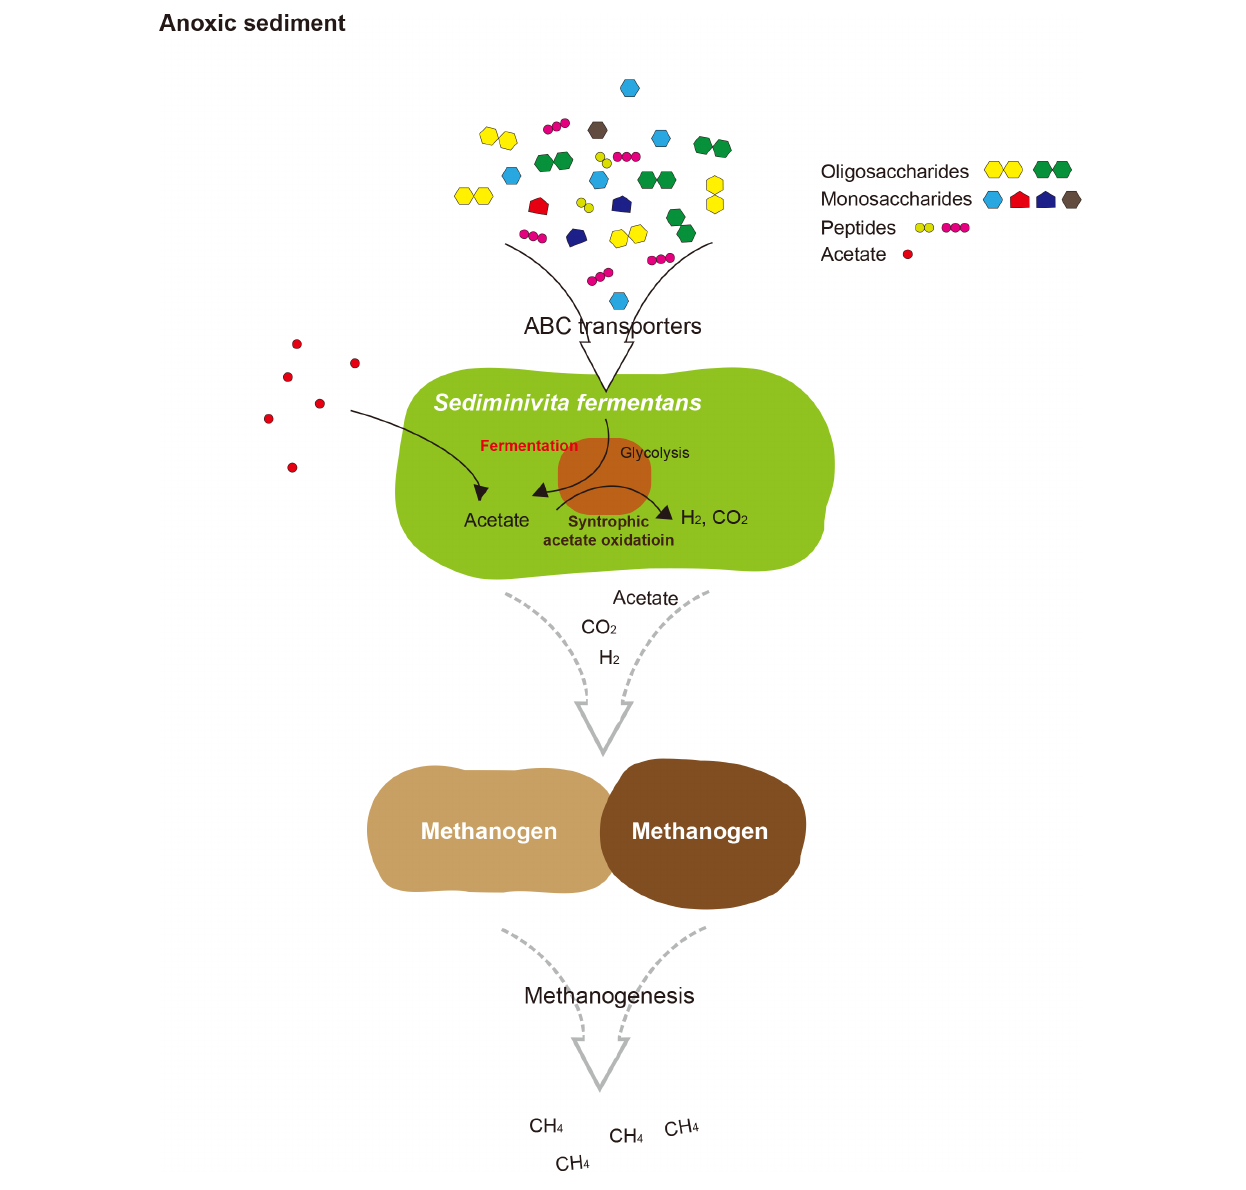
and CO 2 , were present in the RS JS1-cSAG. When